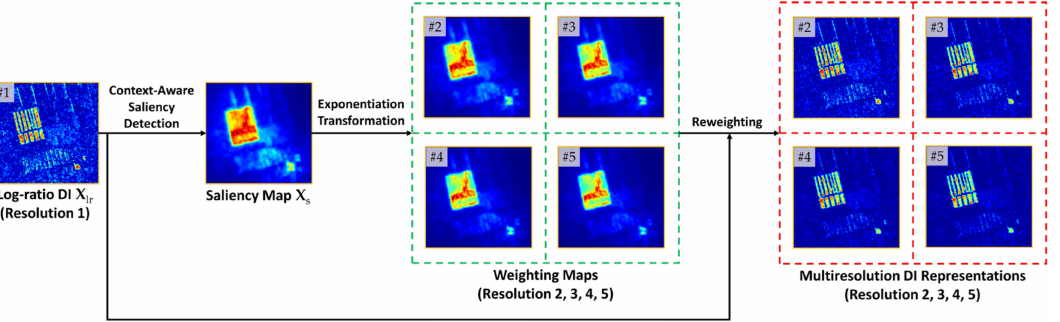
Figure 2. Schematic of multiresolution DI generation. Herein, “resolution” in this article corresponds to different levels of detail, rather than the real range or azimuth resolution in SAR imaging.